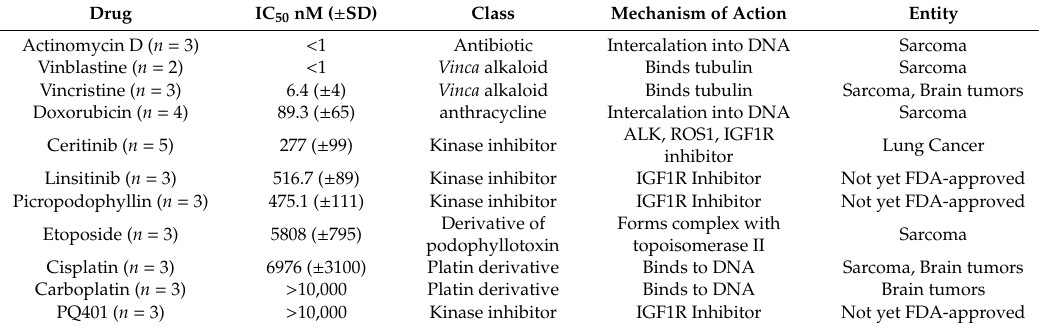
Table 1. Overview of chemotherapeutics and insulin-like growth factor receptor (IGF1R) inhibitors tested in vitro on PhKh1 cells. The IC50, class of the drug, its mechanism of action, and tumor entity generally treated with the drugs are indicated. FDA: Food and Drug